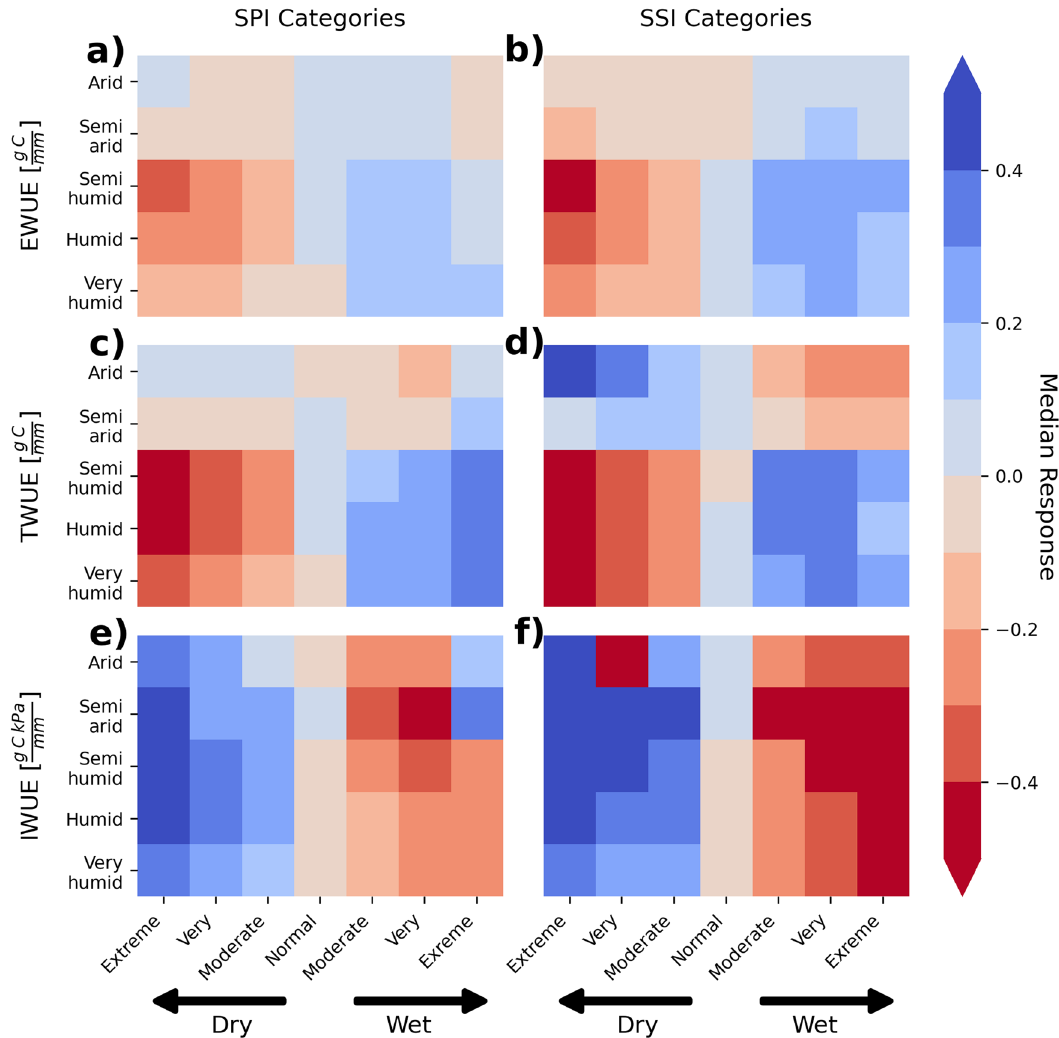
Fig. 3 The magnitude of WUE response to droughts depends on the drought severity and the hydro-climate. Shown here are EWUE ( a , b ), TWUE ( c , d ) and IWUE ( e , f ) median anomalies (color map) to indicate the drought response during instances of standardized precipitation (SPI) ( a , c , e ) and soil moisture (SSI) ( b , d , f ) anomaly categories (x-axes) and hydro-climates (y-axes, Supplementary Fig. S1 and Tables S1 and